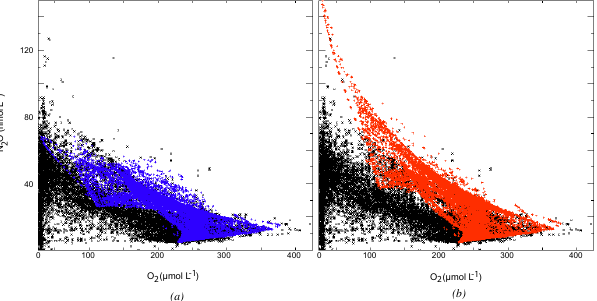
Figure 3. Relationship between O 2 concentration (in µmolL − 1 ) and N 2 O concentration (in nmolL − 1 ) in the MEMENTO database (black) (Bange et al., 2009), compared to model (a) P.TEMP (blue) and (b) P.OMZ (red) parameterizations averaged over the 1985 to 2005 time period from the historical simulation.